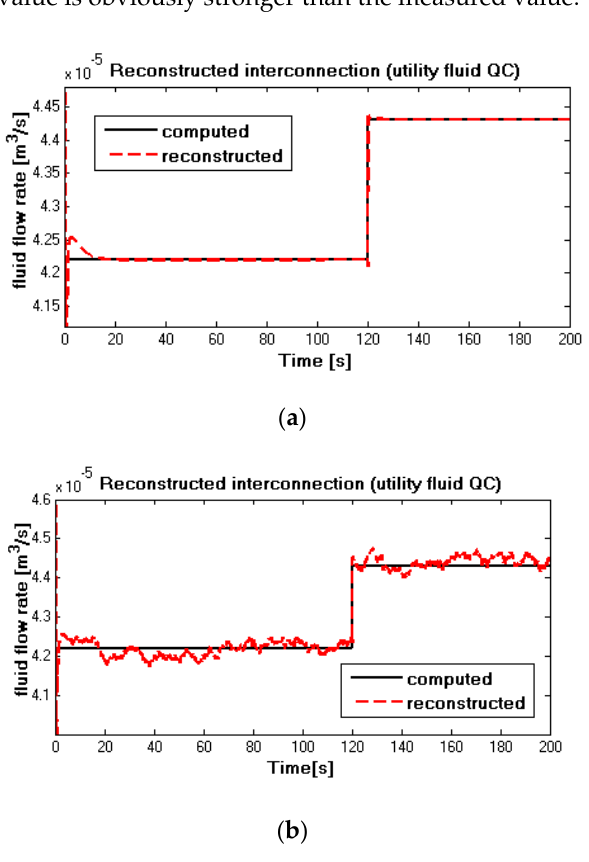
Figure 13. ( a ) Reconstructed and computed Q C (noise-free situation) in case 2; ( b ) reconstructed and computed Q C (noise-corrupted situation) in case